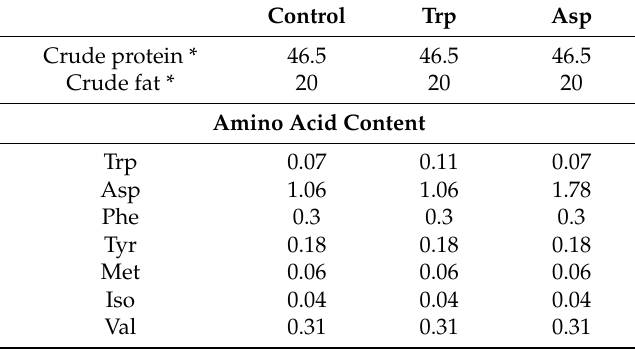
Table 1. Experimental feed analysis (focused on contents of target amino acids and others). Units in % on dry food (mean ± standard deviation (SD); SD < 0.01 in all values). Control Trp Asp Crude protein *